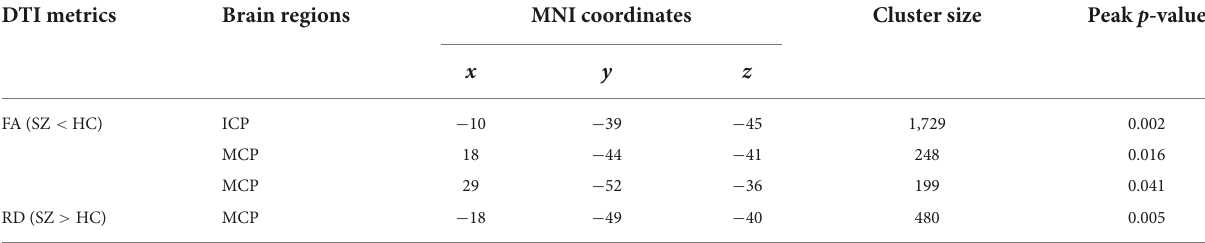
TABLE 2 Significant differences of voxel-wise DTI metrics between SZ and HC. DTI